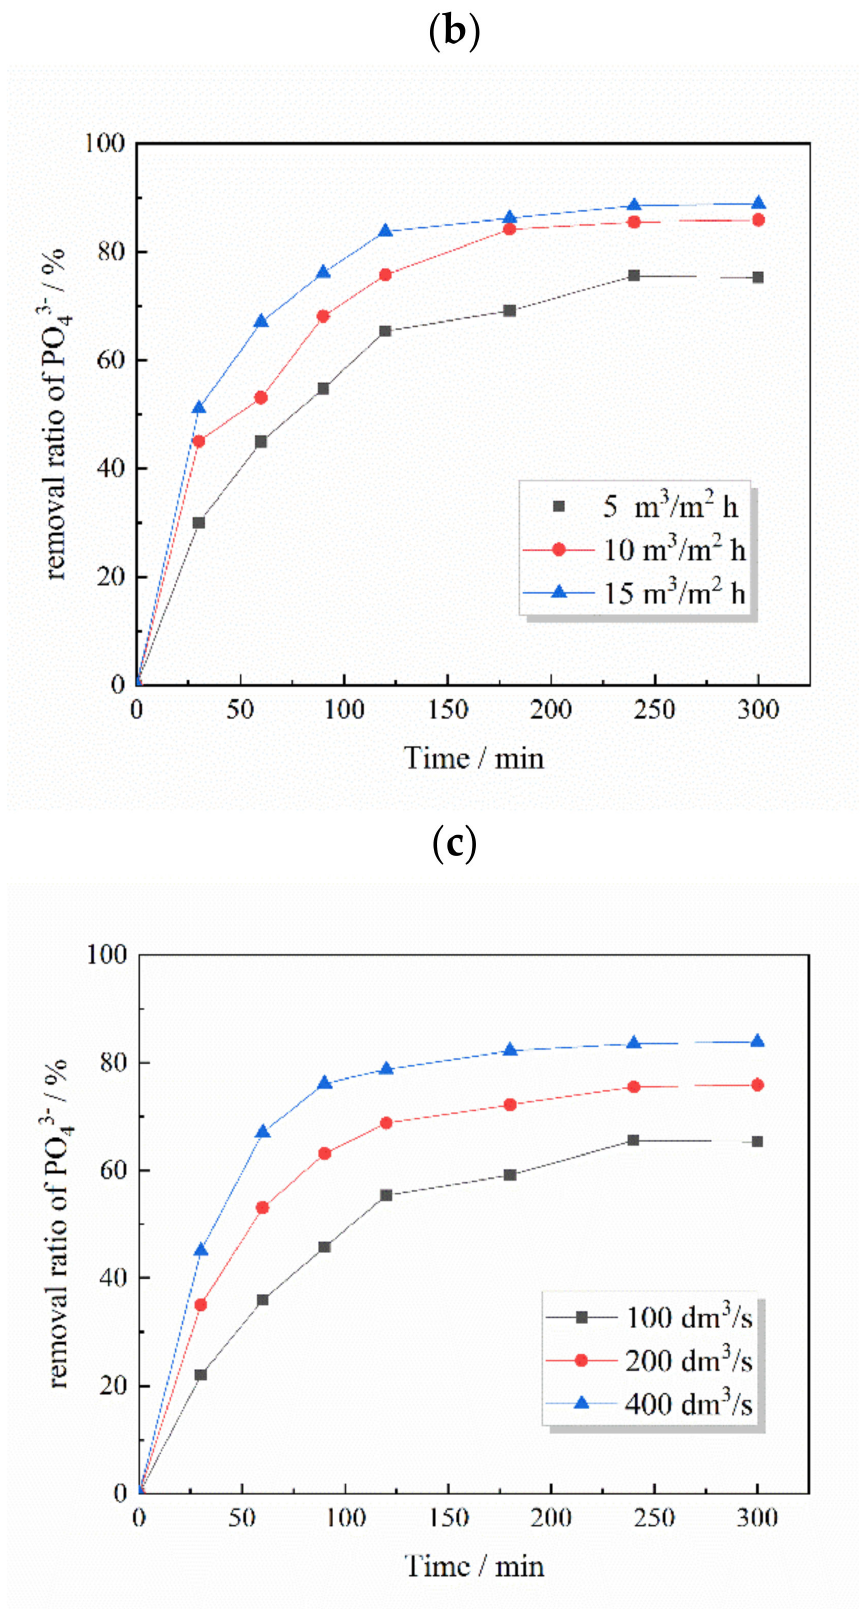
Figure 9. The relationship between the dephosphorization effect of the reactor and the parameters. ( a ) the effect of operation mode on phosphorus removal; ( b ) the effect of aeration rate on phosphorus removal; ( c ) the effect of reflux rate on phosphorus